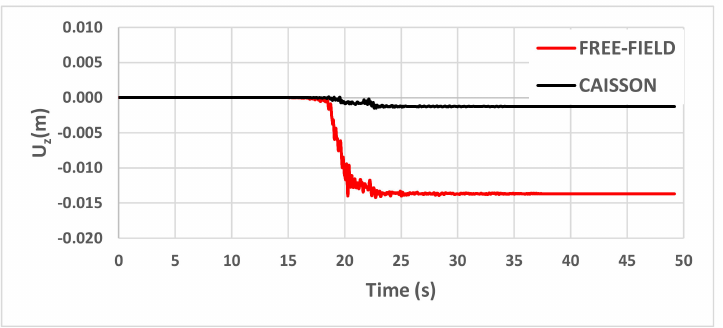
Figure 8. Comparison between the vertical displacement time-histories computed for the 3D model, at the caisson top, and in free-field conditions.